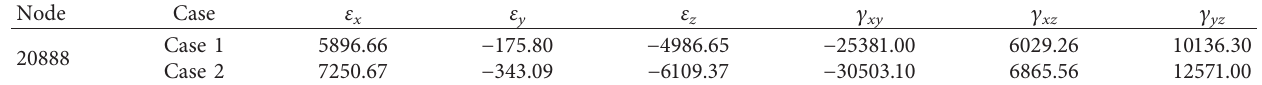
Table 6: Strain components at the critical point (unit: με ).